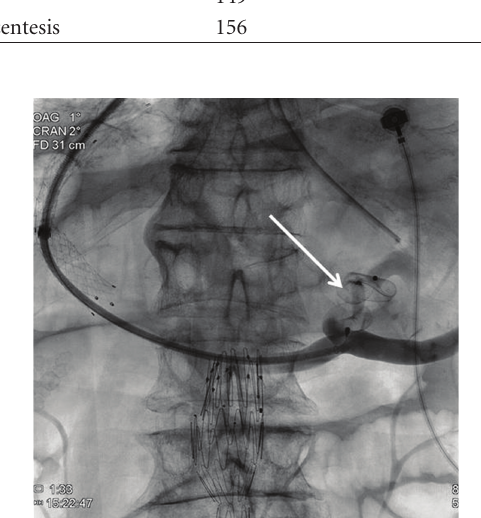
Figure 6: Embolisation of fundal varices using an Amplatzer (cid:2) vascular plug, in conjunction with the TIPS procedure due to persistence of fundal varices filling despite a functional TIPS.